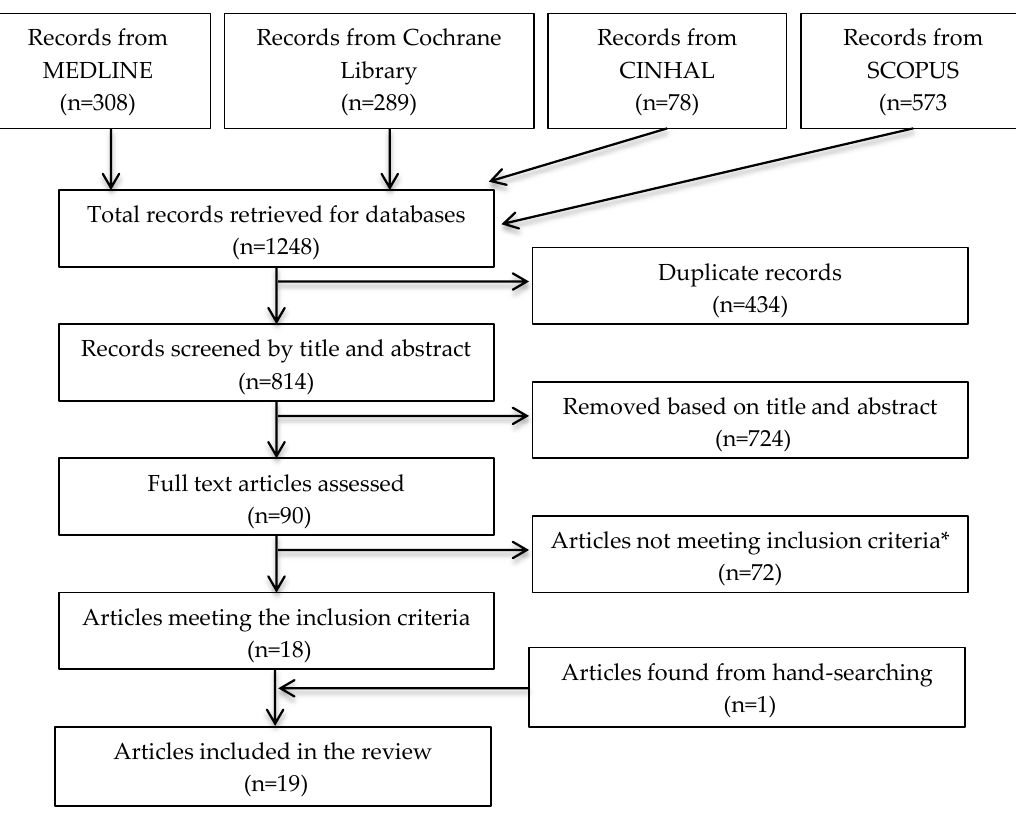
Figure 2. Flow diagram of study selection * Exclusions were in the following order for the following reasons: >2 modifiable risk factors for CVD ( n = 37), Used supplementation ( n = 31), Conducted in non-Western countries ( n = 2), Data could not be separated for interpretation ( n = 2).